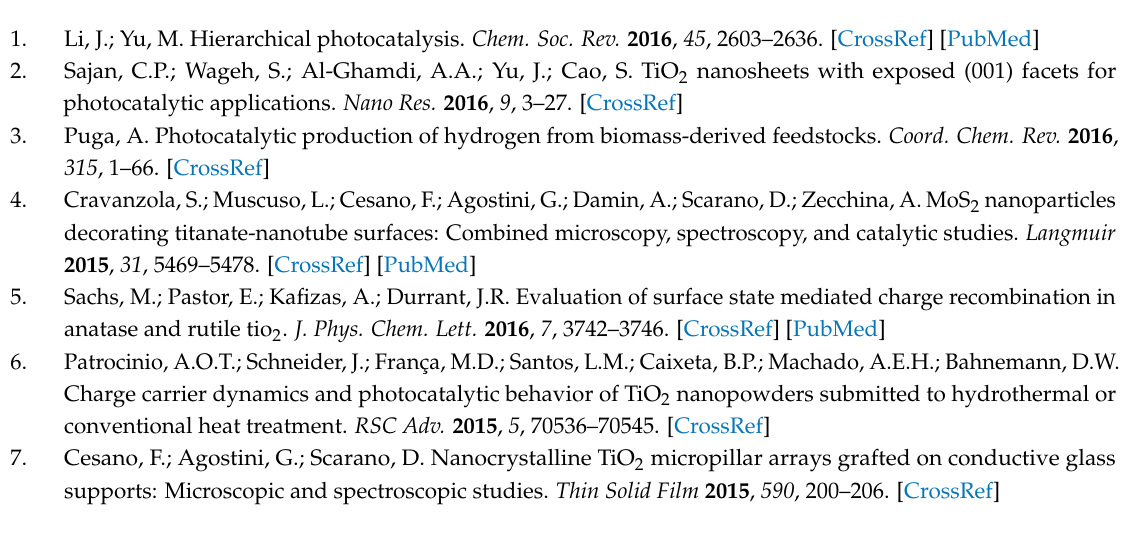
Figure S1: XRD patterns of samples; Figure S2: Evolution of UV-Vis spectra of MB in water exposed under visible